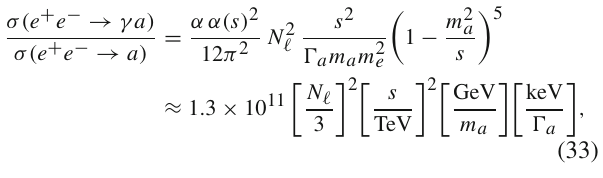
2 a for m (cid:10) (cid:9) m a and 12 m 2 (cid:10)